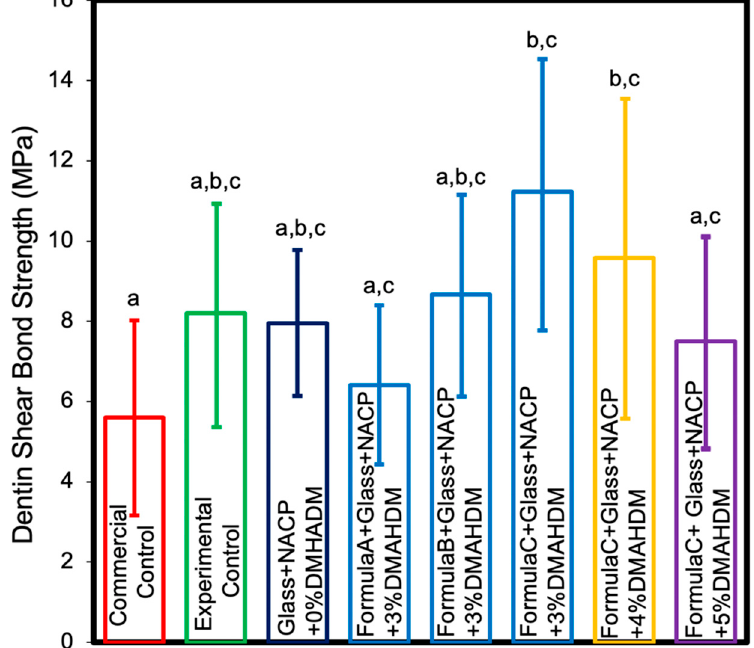
Figure 2. Dentin shear bond strengths (mean ± SD; n = 10). Adding 5% DMAHDM combined with 25% NACP demonstrated comparable shear bond strength to the commercial control ( p > 0.05). Adding 3% and 4% DMAHDM to PEHB with 6% BisGMA combined with 25% NACP demonstrated significantly higher shear bond strength compared to the commercial control ( p < 0.05). Values indicated by different letters are statistically different from each other ( p < 0.05).